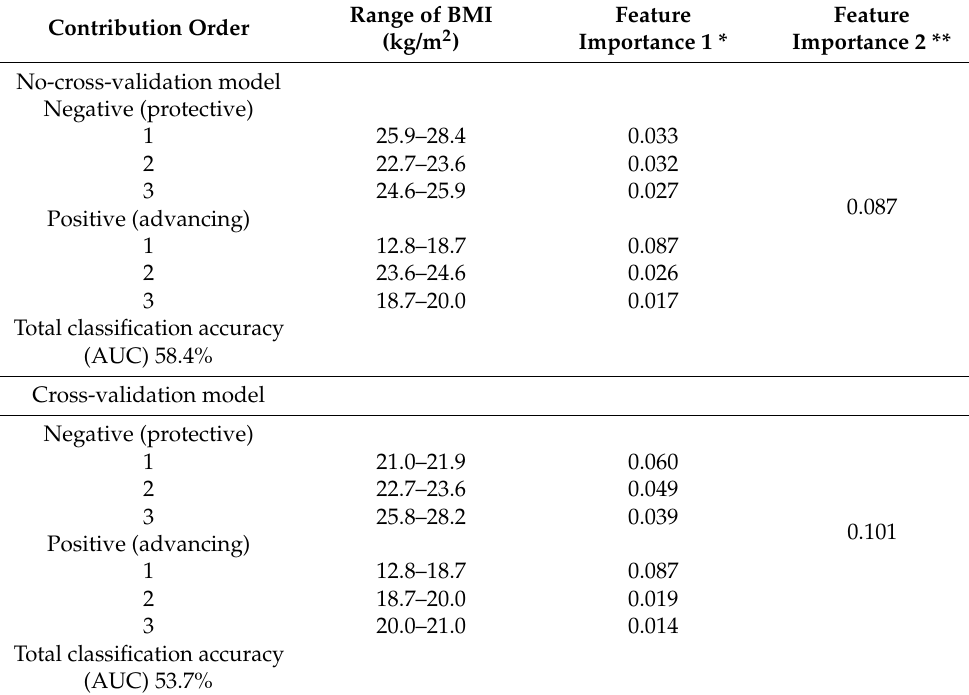
Table 1. Crude (unadjusted) contributions of the ranges of BMI toward all-cause